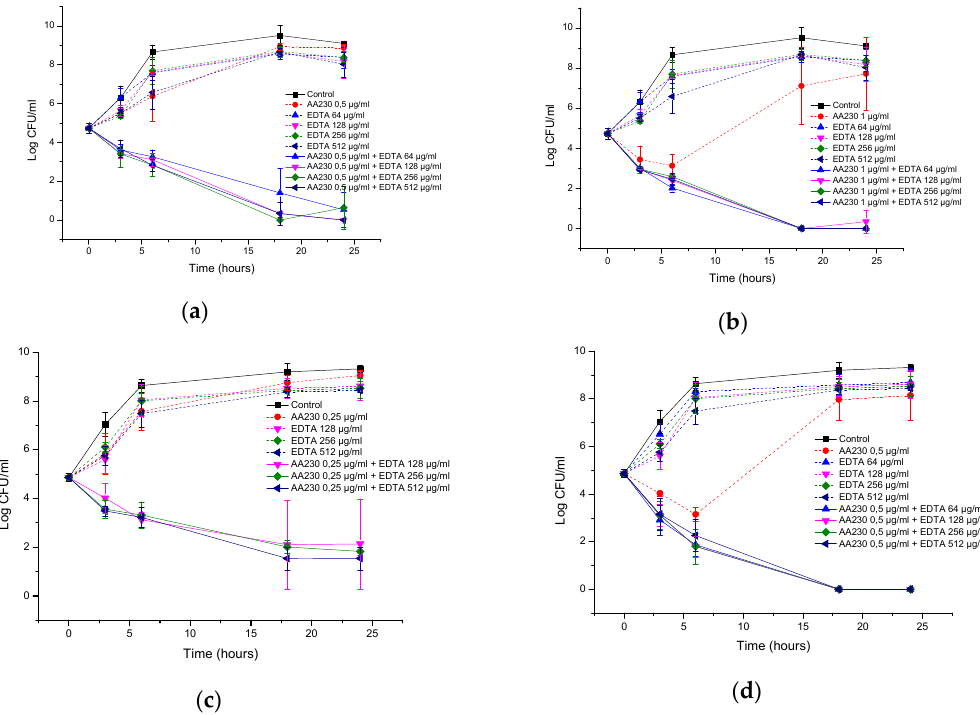
Figure 7. Time-kill curves of antimicrobial peptide AA230 and EDTA used alone and in combination against ( a , b ) Escherichia coli ATCC; ( c , d ) Escherichia coli ESBL.